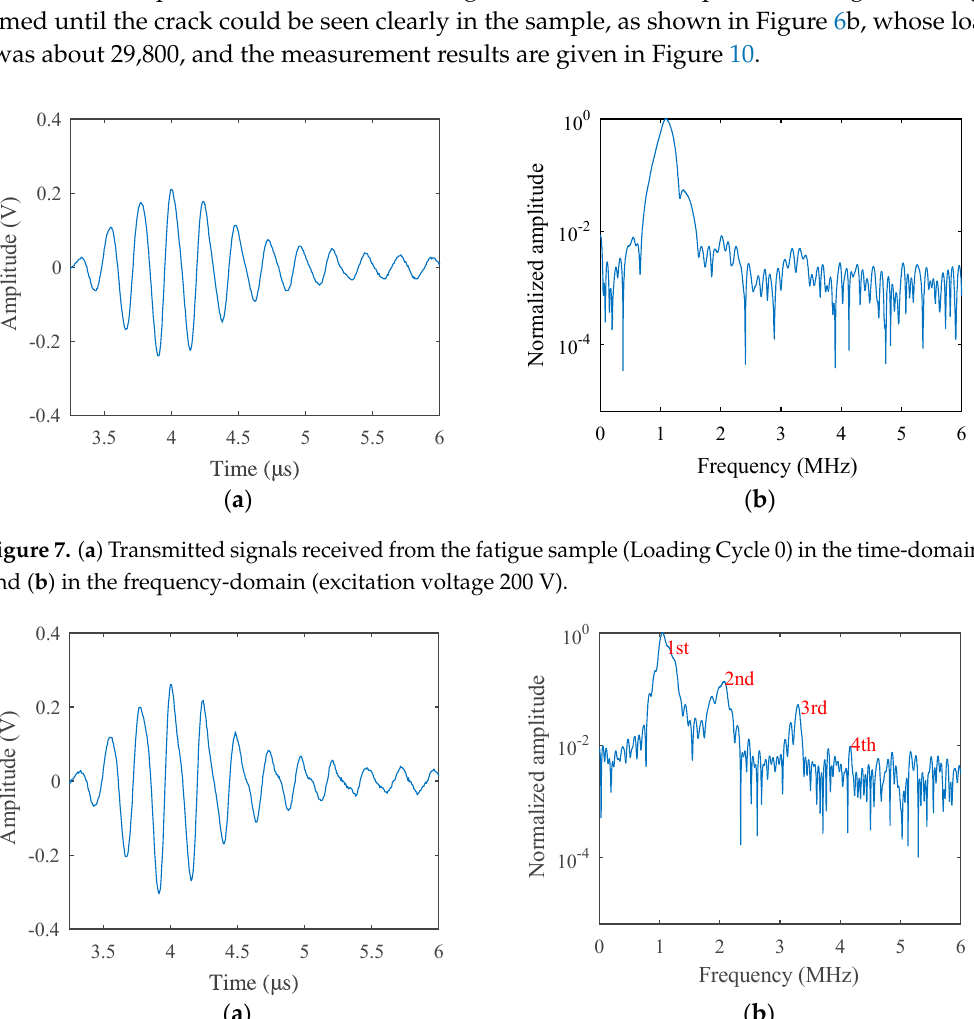
Figure 9. ( a ) Transmitted signals received from the fatigue sample (Loading Cycle 20000) in the time- domain and ( b ) in the frequency-domain (excitation voltage 200 V). The difference is not obvious in the time-domain result in Figure 9a, except that the transmitted energy is a little lower compared with the result in Figure 8a. However, in the spectrum results in Figure 9b, not only the harmonic amplitudes are a little lower, but another frequency component whose frequency is between the fundamental wave and second-order harmonics appears, compared with the results in Figure 8b, which may be caused by the wave scattering of the crack tip or the spatial variation in the stiffness of the springs. These results are much more apparent in Figure 10. As micro-cracks expanded very quickly with continuous loading, the energy of the transmitted wave in this stage was much lower than that in the former situations, as given in the time-domain result, which was consistent with the spring model result. In addition, more spectrum components appeared in the spectrum result, as marked with rectangles in Figure 10b. Because the crack surface was rough and curved, this may have led to more scattering waves and generated more other intermediate frequency components in the result. It is very complicated to describe in theoretical models and will be studied in our next work.